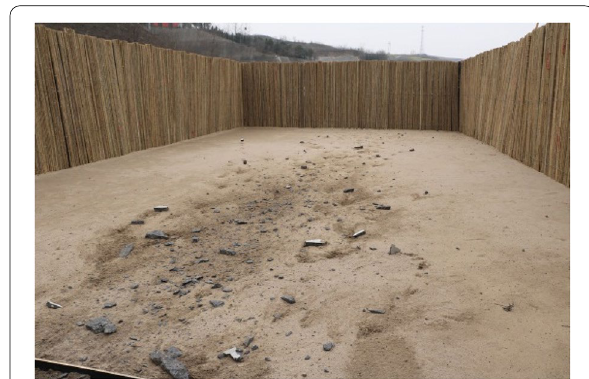
Fig. 16 Test site fragment distribution map.